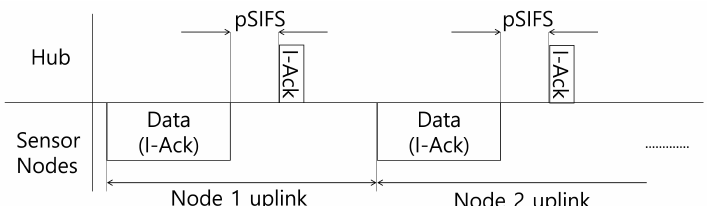
Figure 3. Example of scheduling in MAP. I-Ack, immediate-Ack. pSIFS, Short Inter-Frame Spacing.